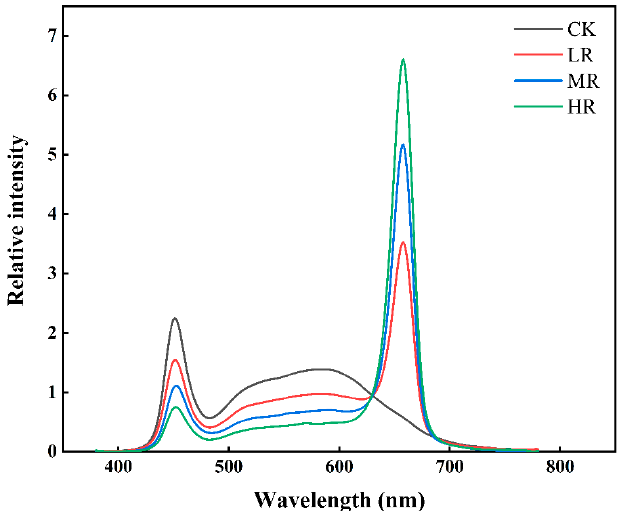
Figure 1. Photon flux density in the four treatments. The spectral distribution was measured by a spectrometer (ALP ‐ 01, Asensetek, Taiwan, China). Table 1. Lighting parameters of treatments.